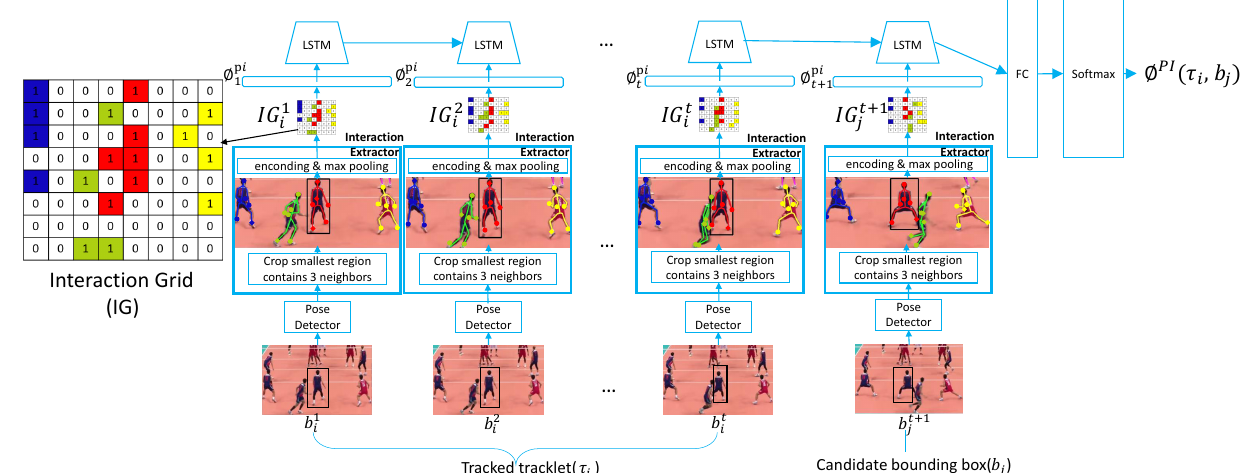
Figure 4. The architecture of Posed-based Interaction Stream (PIS). A pose detector is applied to obtain pose information of an athlete from previous t frames. The interaction grids of this athlete are calculated between his/her closest 3 neighbors at each frame. Then we apply an LSTM to encode interaction information for this athlete and compare it with candidate boxes b j generated by the detector at timestep t + 1. Finally, the LSTM outputs a similarity score φ PI ( τ i , b j ) indicating the probability of the candidate boxes containing the same